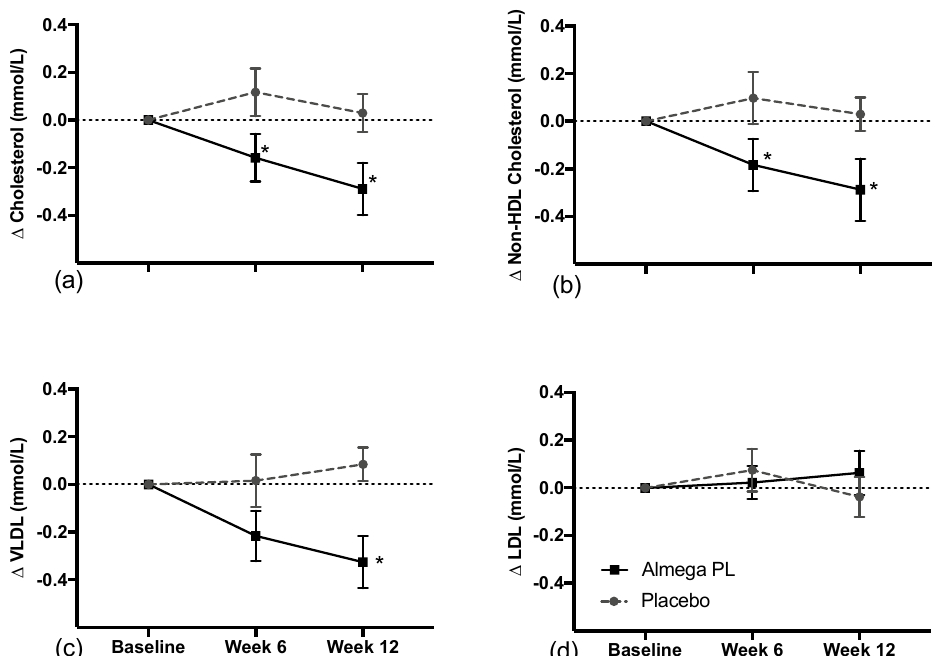
Figure 3. Change in total cholesterol ( a ), non-HDL-cholesterol ( b ), VLDL ( c ) and LDL ( d ) in plasma (mmol/L) of 76 participants with higher baseline cholesterol over the 12-week intervention Values represented as mean ± SEM, * change from baseline significantly different to placebo, p < 0.05. Table 4. Inflammatory, general safety markers, and anthropometric results for both the Almega ® PL group and placebo